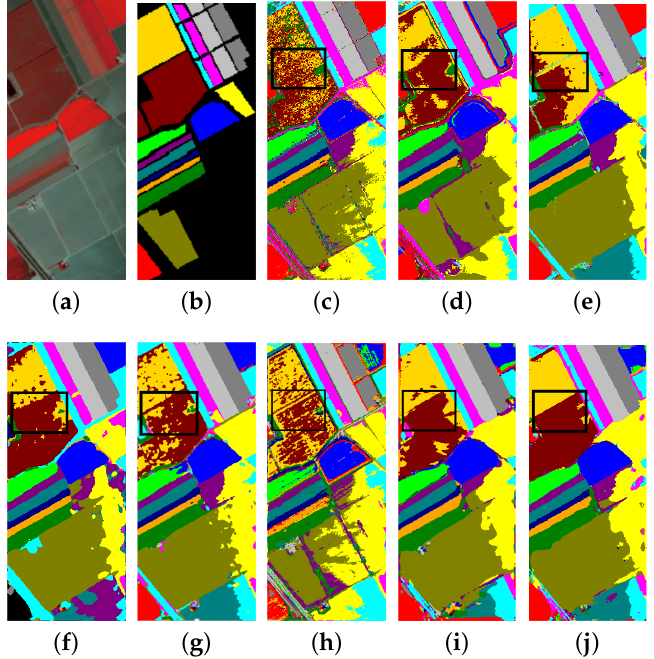
Figure 12. Classification maps for the Salinas dataset with 10 labeled training samples per class.